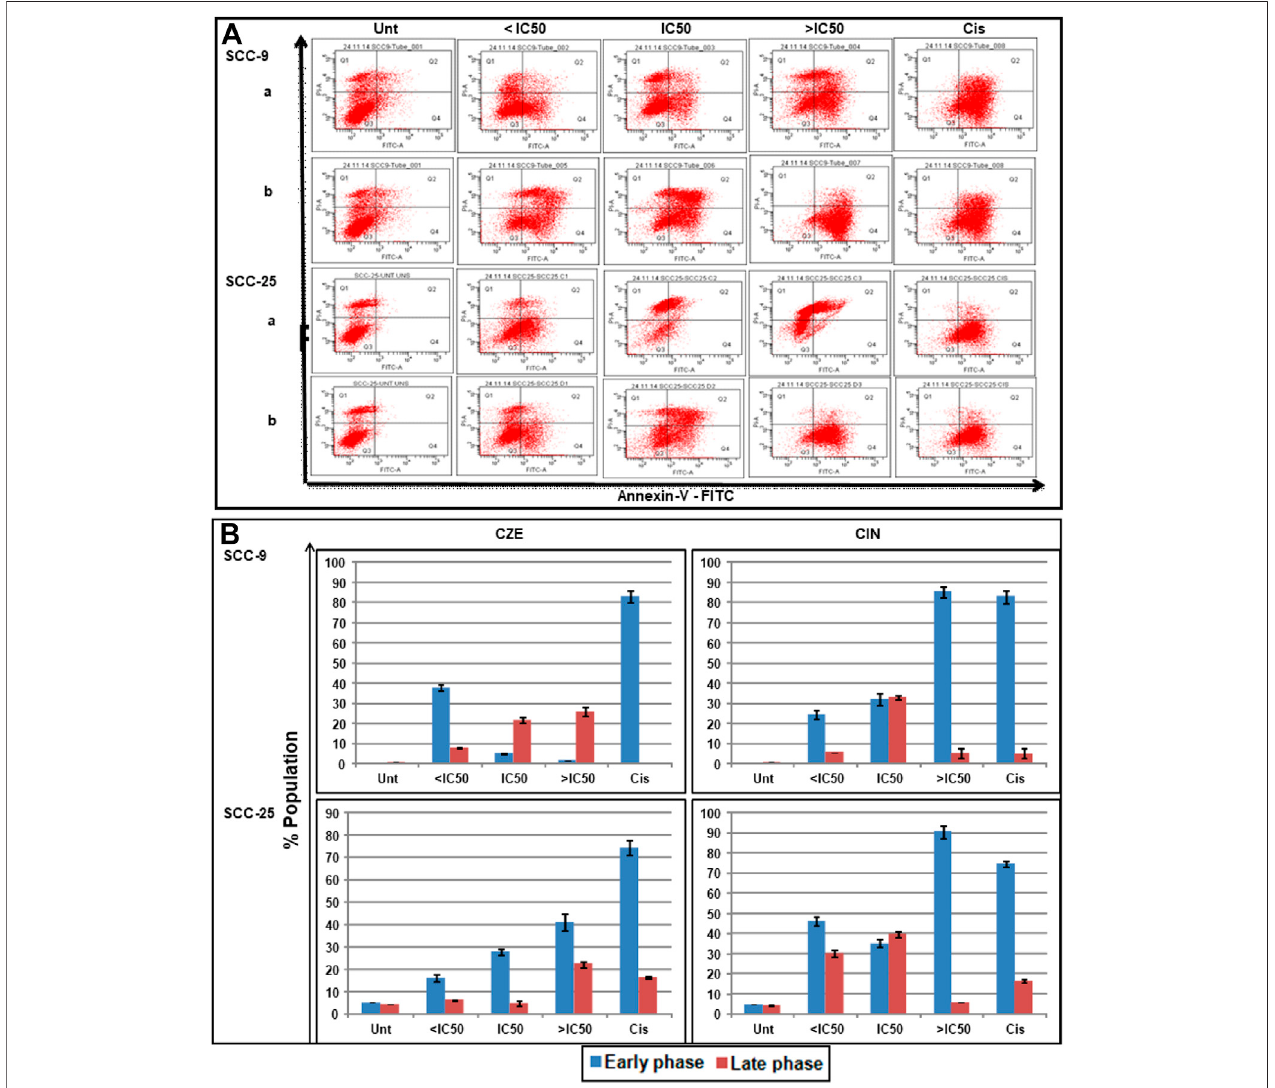
FIGURE5| ApoptoticeffectsofCZEandCIN onoralcancercellsasobservedAnnexin-V-FITCdouble staining.Theuntreated, CZE(50, 100,and200 μ g/ml),CIN (20, 40, and 80 μ m) and cisplatin (2 μ g/ml) treated cancer cells (SCC-9 and SCC-25) cells were subjected toAnnexin-V-FITC double staining at 48 h (A) Representative quadrant plots from fl ow cytometry analysis showing dose-dependent increase in apoptotic cells. Quad I (Top-left): Necrotic (Annexin-V-FITC - /PI + ); Quad II (Top-right): lateapoptoticcells(Annexin-V-FITC + /PI + );QuadIII(Bottom-left):livecells(Annexin-V-FITC - /PI − );QuadIV(Bottom-right):earlyapoptoticcells(Annexin-V-FITC + /PI − ) (B) Bar graphs showing the percentage distribution of cancer cells (mean ± SD) in various phases of apoptosis after treatment with different concentrations of Cinnamomum zeylanicum extract (CZE), cinnamaldehyde (CIN) and Cisplatin (Cis).